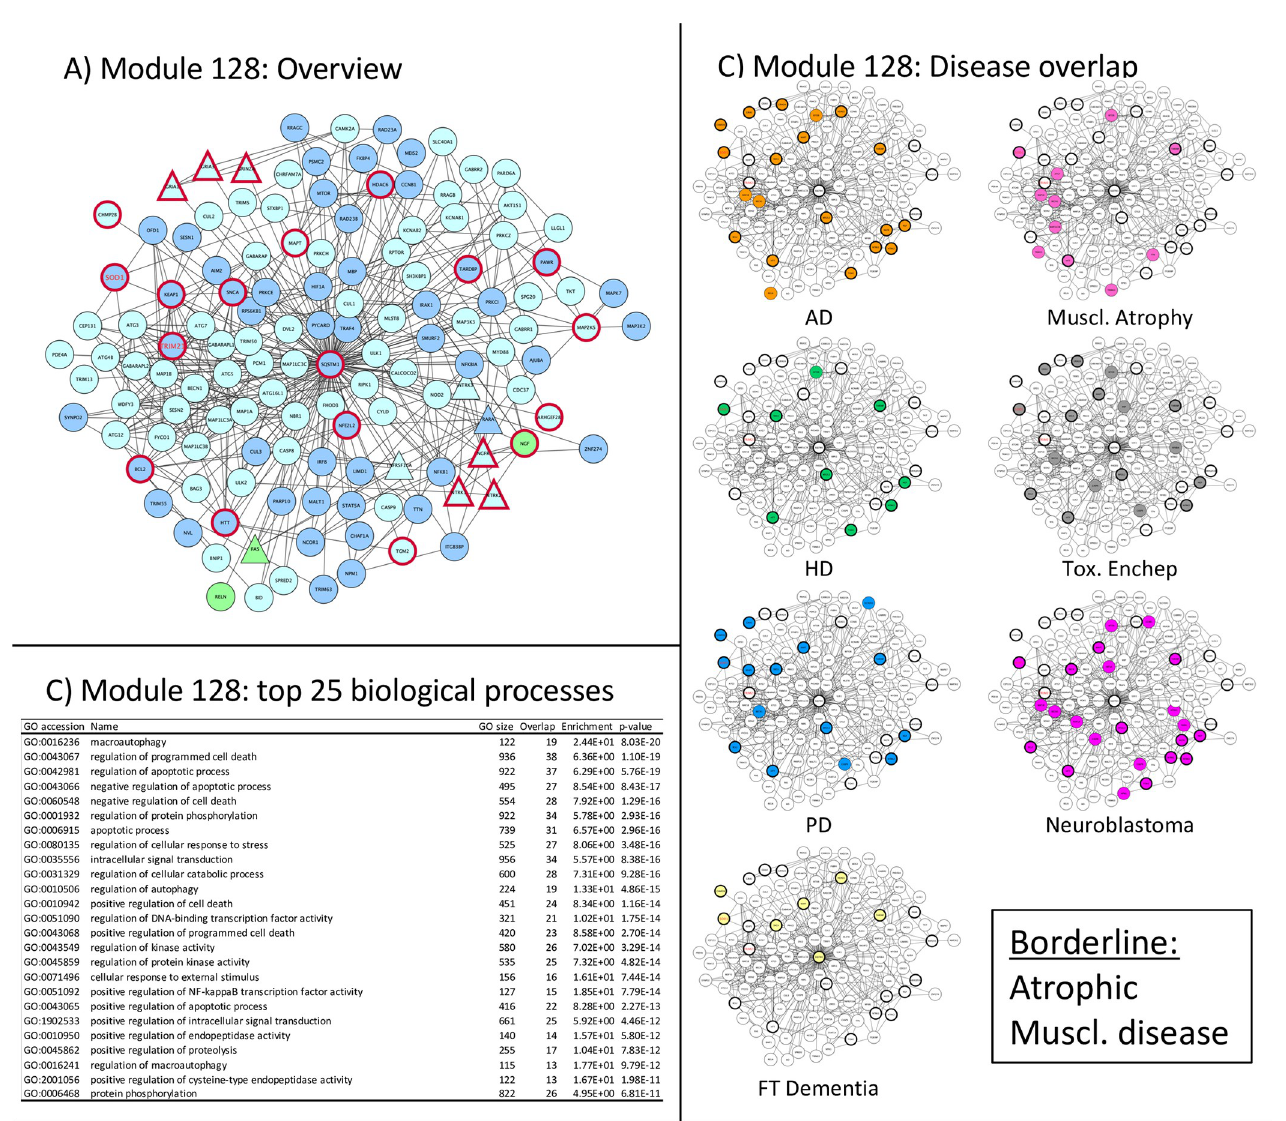
Fig 8. Module 128 –stress and apoptosis related. Panel A: thick red border: gene/protein annotated to be ALS-associated on any of the 7 lists. Large red label: gene/protein with GWAS evidence. Triangular shaped nodes: receptors (UniProt keyword). Node colors indicate subcellular location (UniProt keywords): Blue = Nuclear, Green = Secreted, Purple = conflicting nuclear/secreted, cyan = neither nuclear nor secreted (likely cytosolic). Panel B: Gene Ontology overrepresentation analysis. Panel C: Thick border: ALS-associated (as panel A), Colored node: Disease-associated gene/protein.